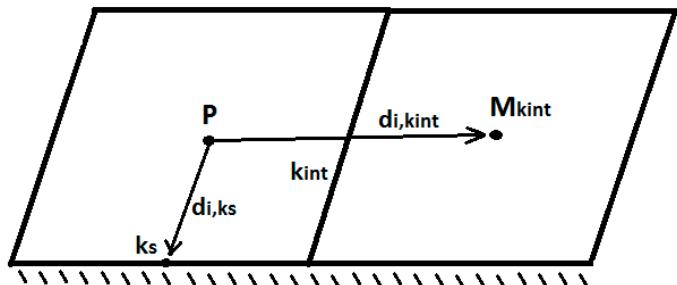
Figure 1. Computational mesh.